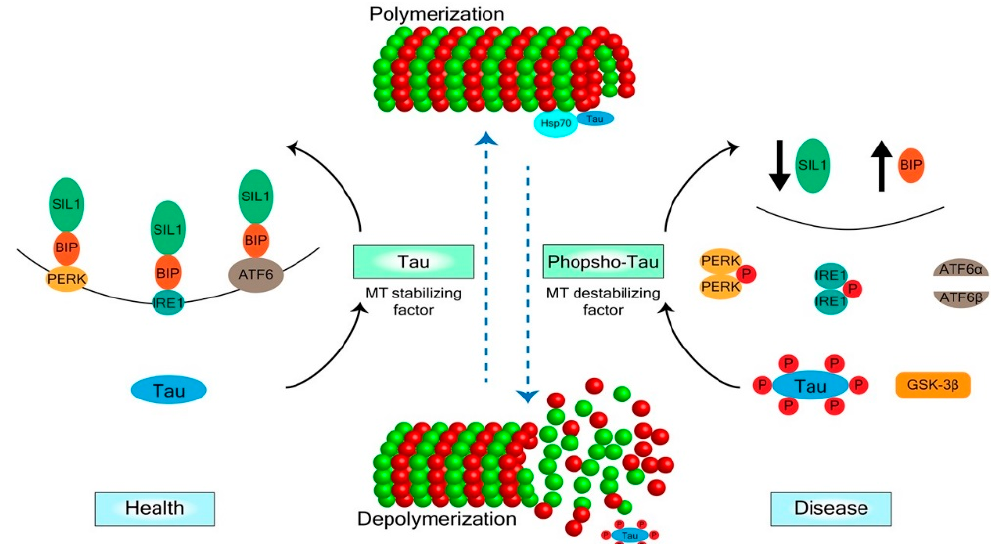
Figure 2. Mechanisms of Tau Regulation: Tau and the Endoplasmic Reticulum Stress Response during Progressive Degenerative Disorders of the CNS. Here we propose a model for tau-induced progressive degenerative disorders. Tau, microtubules (MTs), and the ER stress signaling are affected by each other. Tau stabilizes the MTs, whereas phosphorylated tau, MT instability, and the ER stress response progressively devastate CNS cells. The Bip chaperone frees sensor proteins (PERK, ATF, and IRE) that signal the inhibition of protein translation and promote apoptosis.